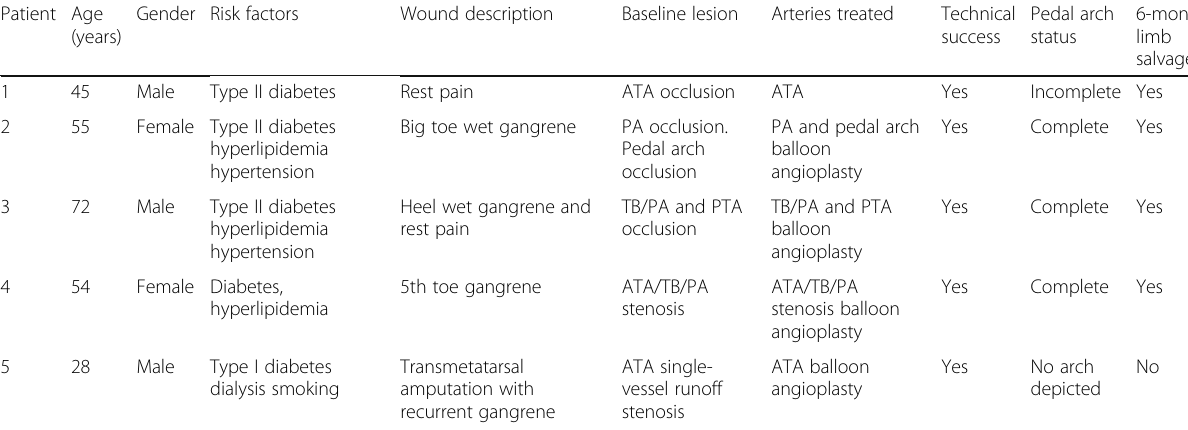
Table 1 Patients ’ demographic and outcomes Patient Age Gender Risk factors Wound (years)